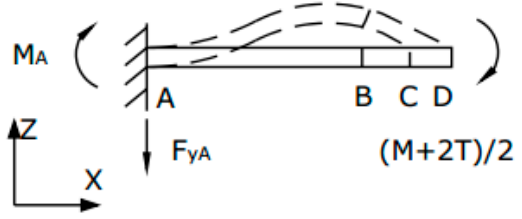
Figure 6. Stress situation of beam and left part of center-block.